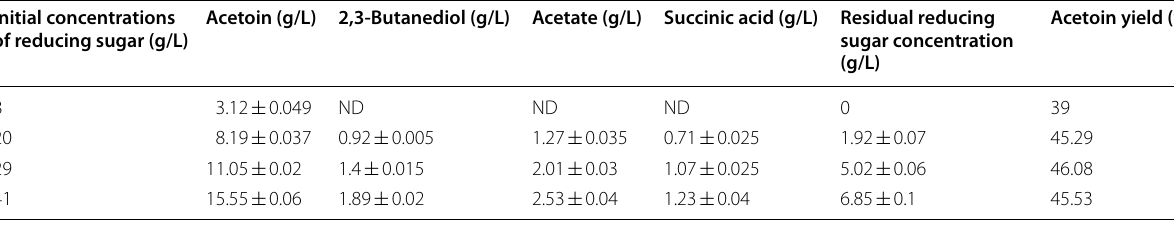
ND Not Detected